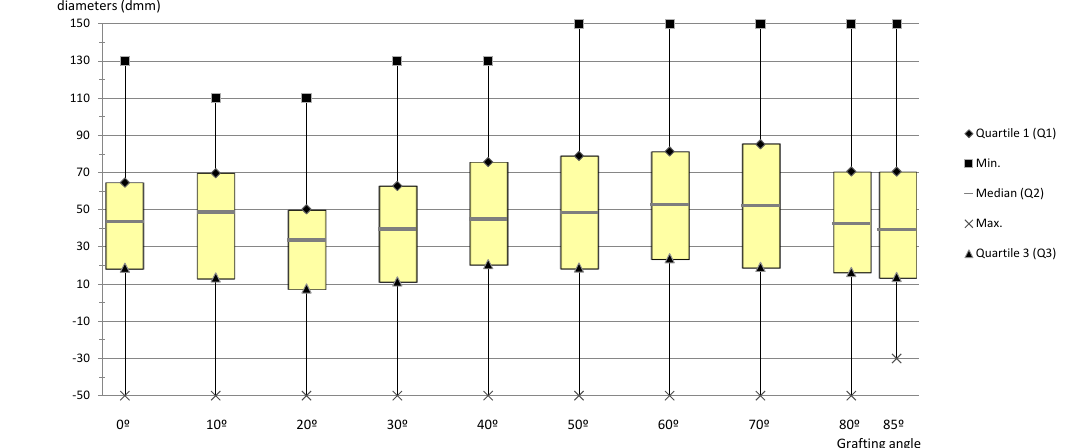
Figure 5. Distribution of successful grafts according to the differences between diameters of plants for each angle of union. This graph represents the density function of successes for each cutting angle (1 dmm is a tenths of a millimeter, 10 − 4 m). A slightly greater amplitude between quartiles is appreciable at angles between 50 ◦ and 70 ◦ degrees, which indicates a greater tolerance in this range to the disparity of diameters.